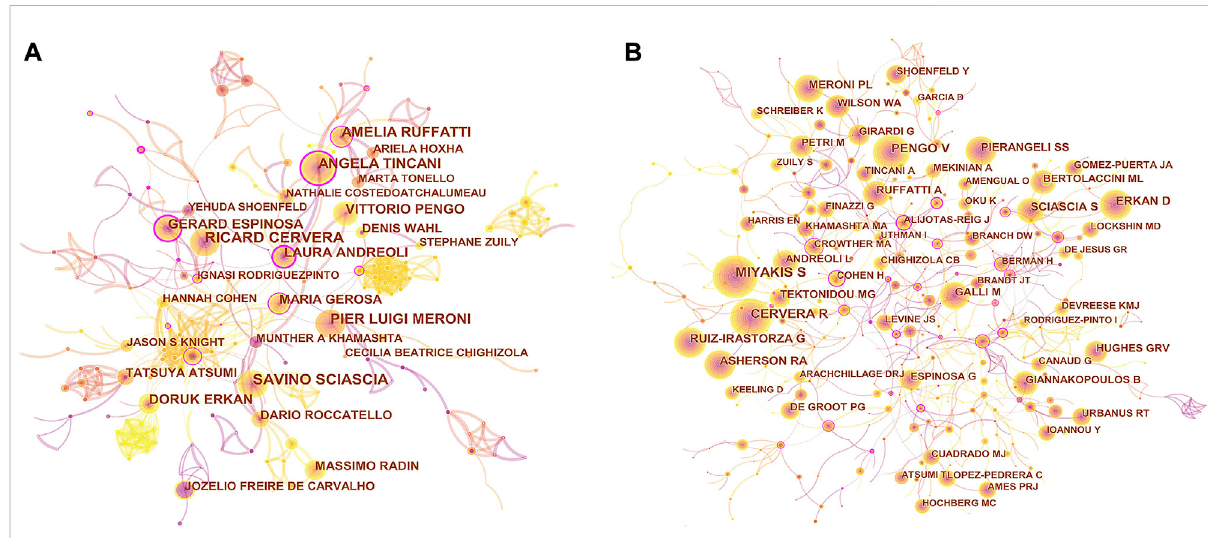
FIGURE 3 (A) CiteSpace visualization map of authors in APS research. (B) CiteSpace visualization map of co-cited authors involved in APS. Each circle represents an author, and the size of the circle is proportional to the publication count (A) or the number of citations (B) . The circles with higher centrality( > 0.1)aredisplayedwithpurplerings.Thelinesrepresentthestrengthoftheco-authorship (A) orco-citedrelationship (B) ,withthickerlines representing stronger collaboration (A) or relevancy (B) . The color of the line represents the time of the fi rst co-authorship, with a more yellow color meaning closer to 2021 and a more red color meaning closer to 2012.